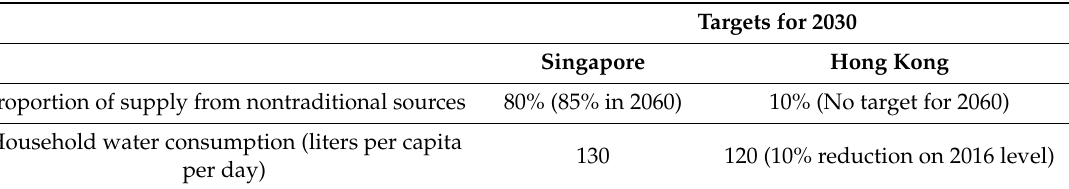
Table 1. Policy targets in Singapore and Hong